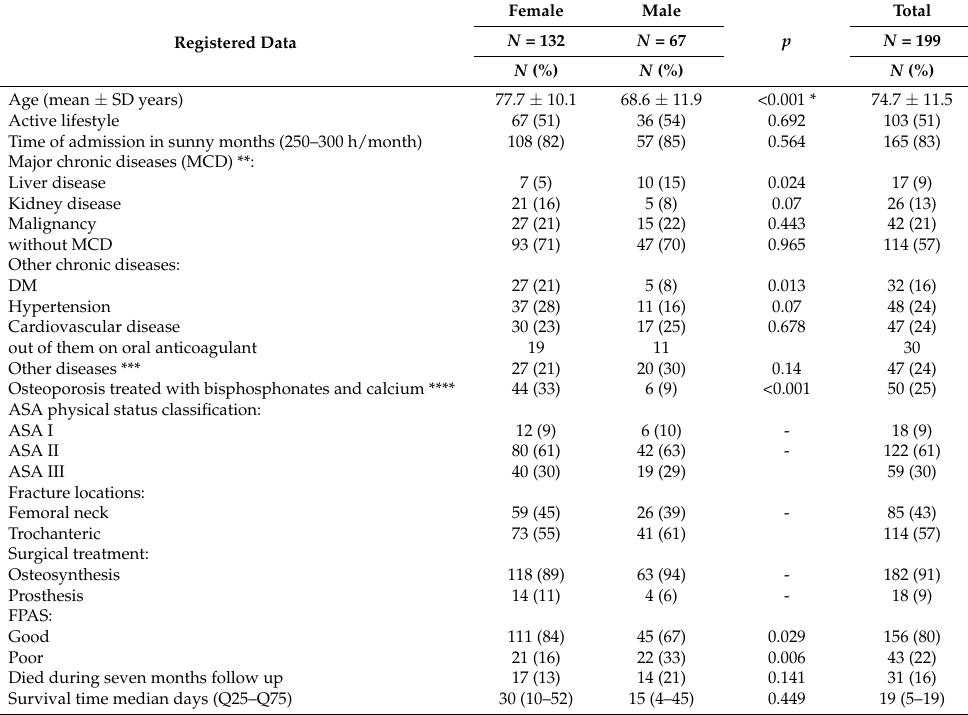
Table 1. Main characteristics of patients with hip